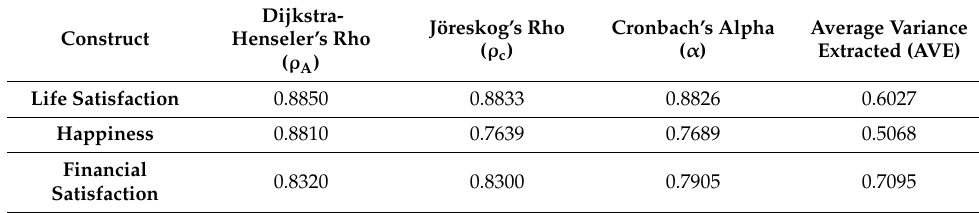
Table 1. Construct reliability and